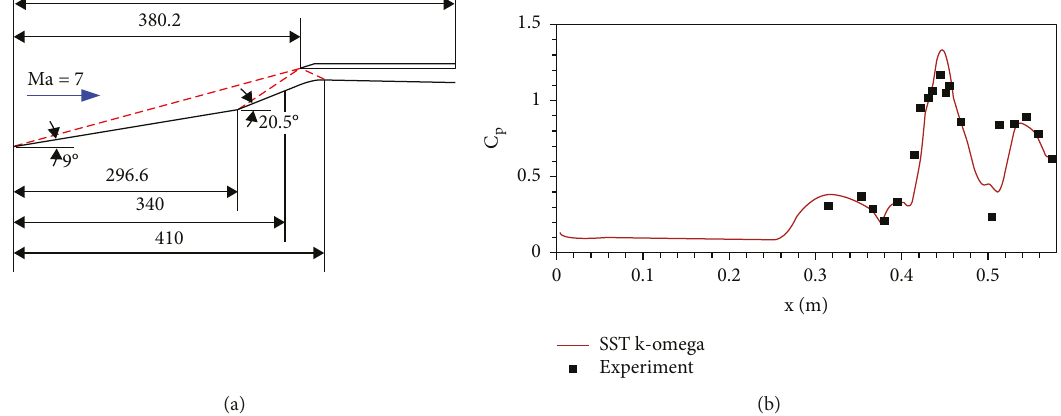
Figure 3: (a) Con fi guration of the hypersonic inlet model GK01 extracted from [16] for validation. (b) Comparison of the pressure distribution along the compression surface between numerical simulation and